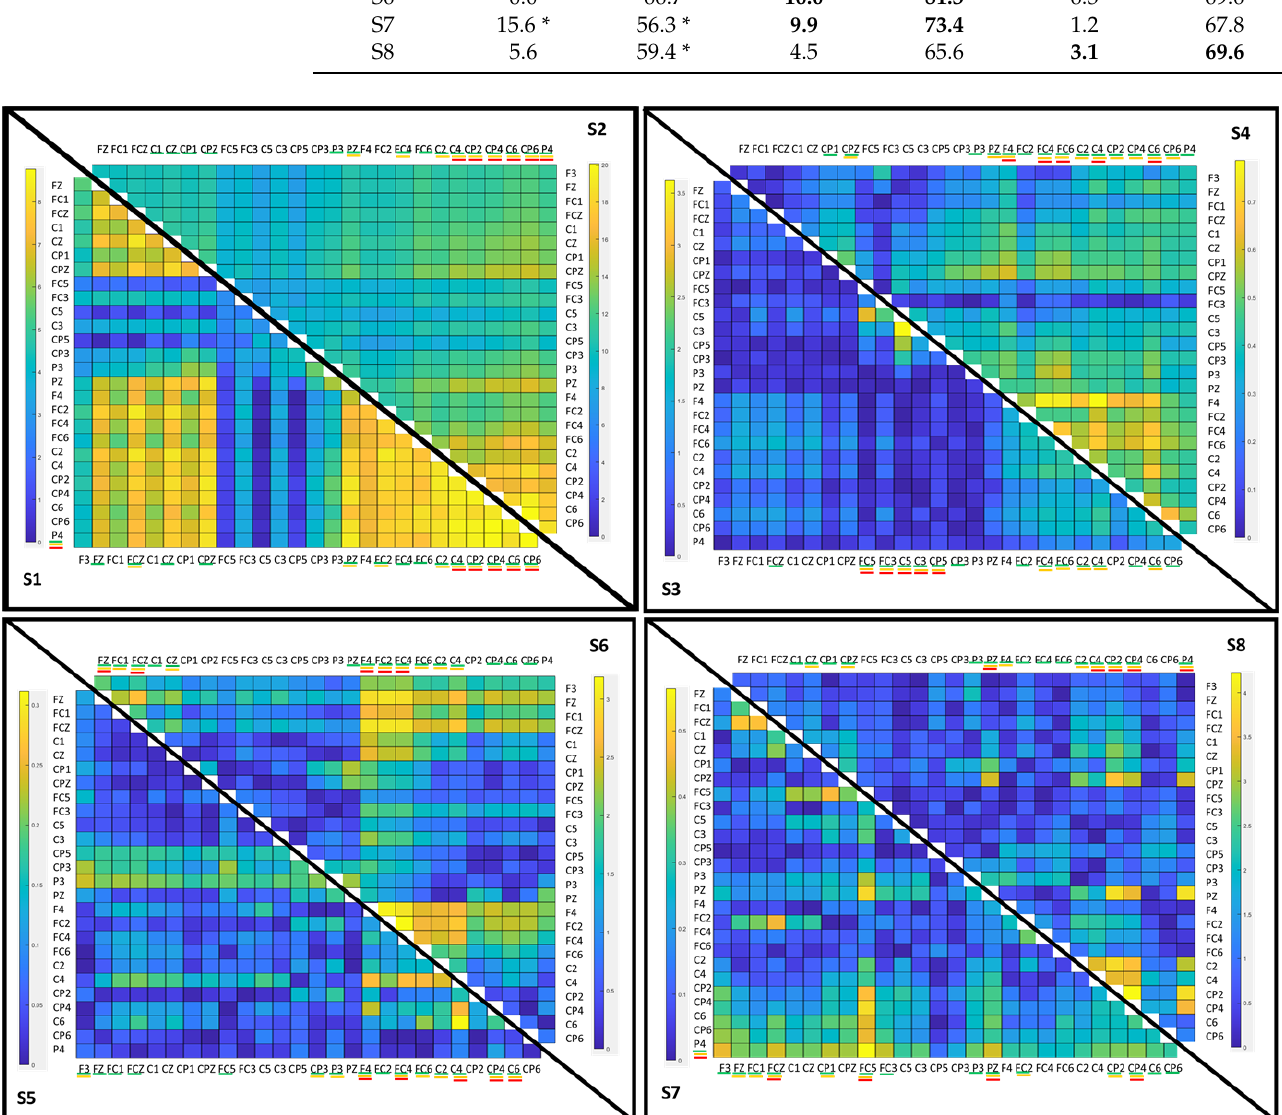
Figure 5. Color map of the upper diagonal of the matrix of differences between the mean of the matrices of the monotonous walk and change intention classes for each of the subjects in the best configurations in Table 4. The best electrodes for the selection of 15, 10 and 5 are indicated respectively underlined with colors: green, yellow and